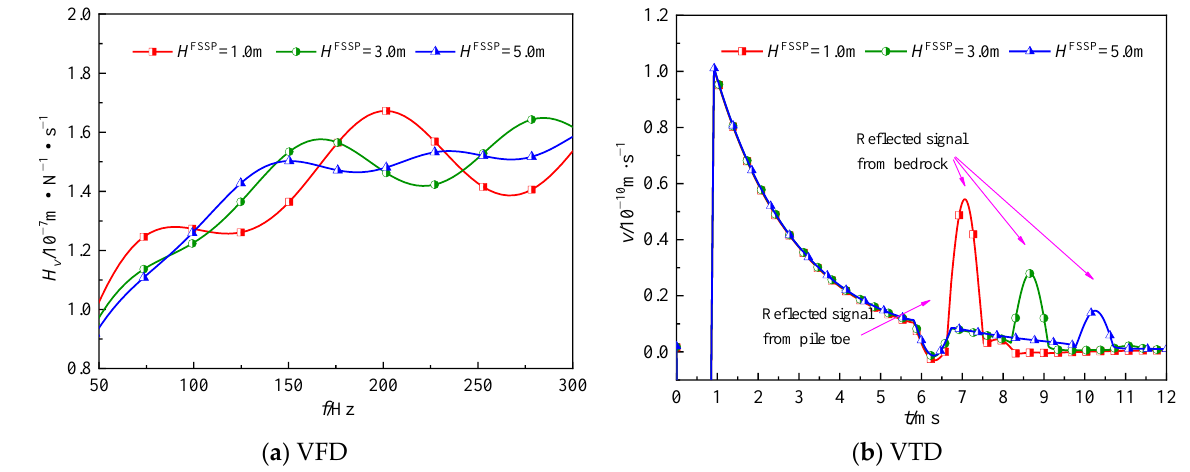
Figure 5. Influence of the length of the FSSP on the vibration velocity of the pile.